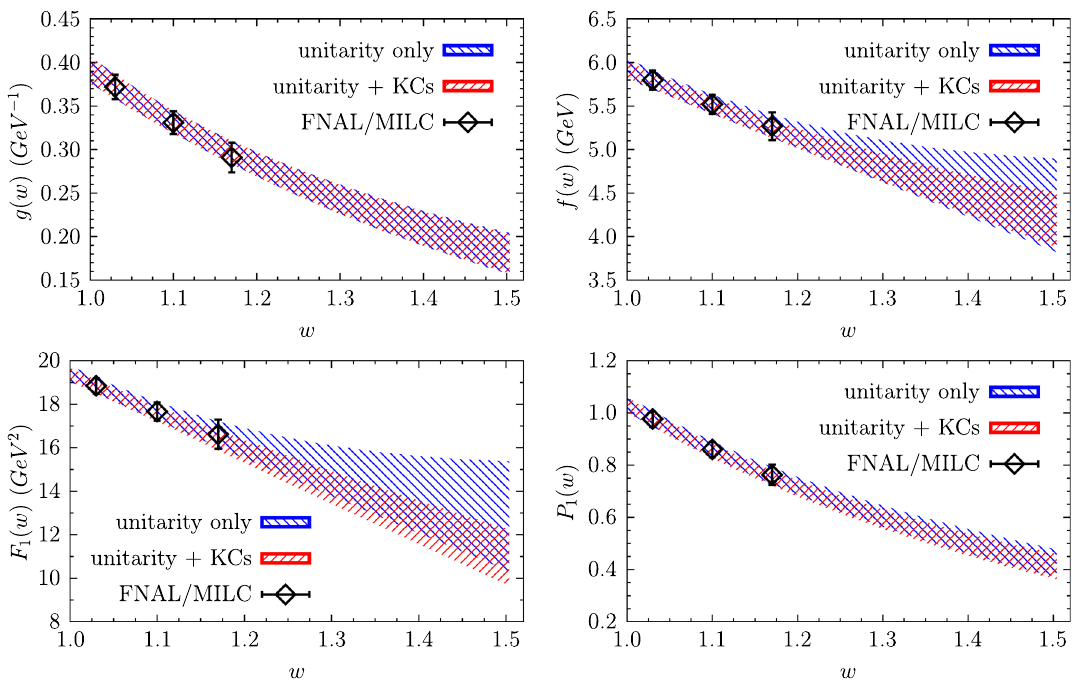
Fig. 1 The bands of the FFs g (w) , f (w) , F 1 (w) and P 1 (w) computed by the DM method after imposing either the unitarity filters only (blue bands) or the unitarity filters and the two KCs (1)–(2) (red bands). The FNAL/MILC values [1] used as inputs for the DM method are represented by the black